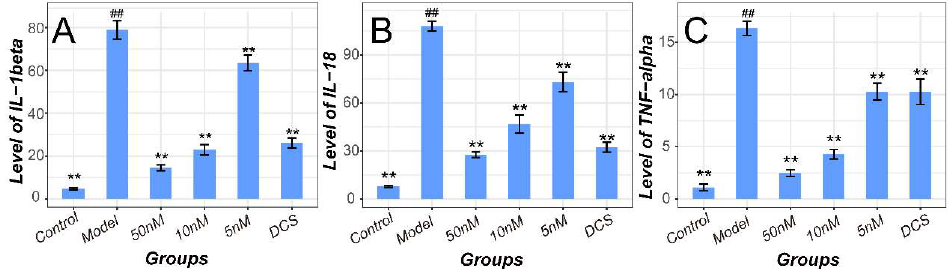
Figure 8. Quantification of supernatants cytokines related with NF-κB and NLRP3/Caspase-1 pathways in all cellular groups at 48th h ( A ) IL-1β, ( B ) IL-18, ( C ) TNF-α levels in all groups. DCS, Diclofenac sodium. ## p < 0.01 vs. Control. ** p < 0.01 vs. Model.